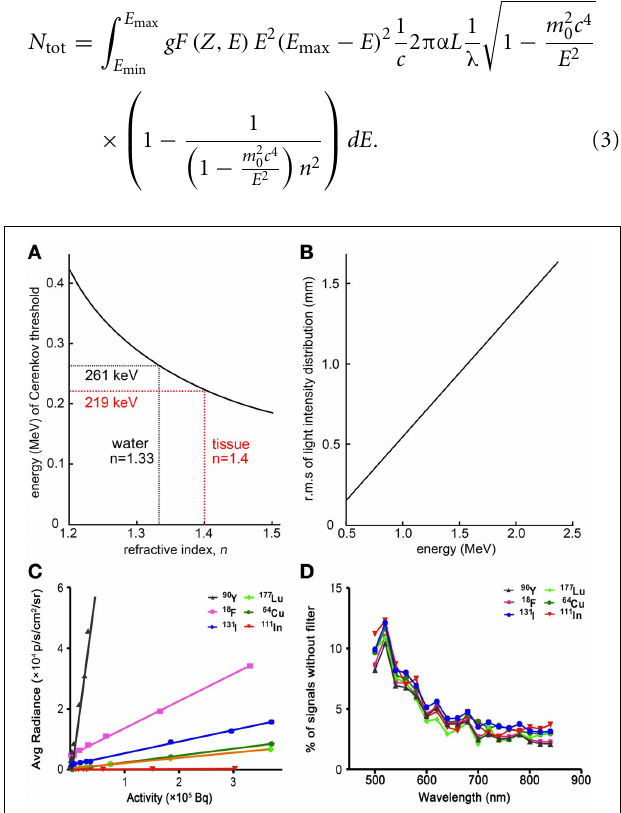
FIGURE 1 | Basic physics of CL. (A) Threshold of charged particles energy for CL production as a function of refractive index, n . (B) The CL intensity distribution as a function of the charged particles energy. (C) Average CL intensity produced by various radionuclides. It showed the CL intensity of all tested radionuclides except for 99m Tc were highly sensitive to the radioactivity. (D) The CL spectra of various radionuclides. Similar spectra were observed from different radionuclides as the signals of CL will decrease with the increasing of wavelength ( C,D were adapted with the permission of Liu et al.